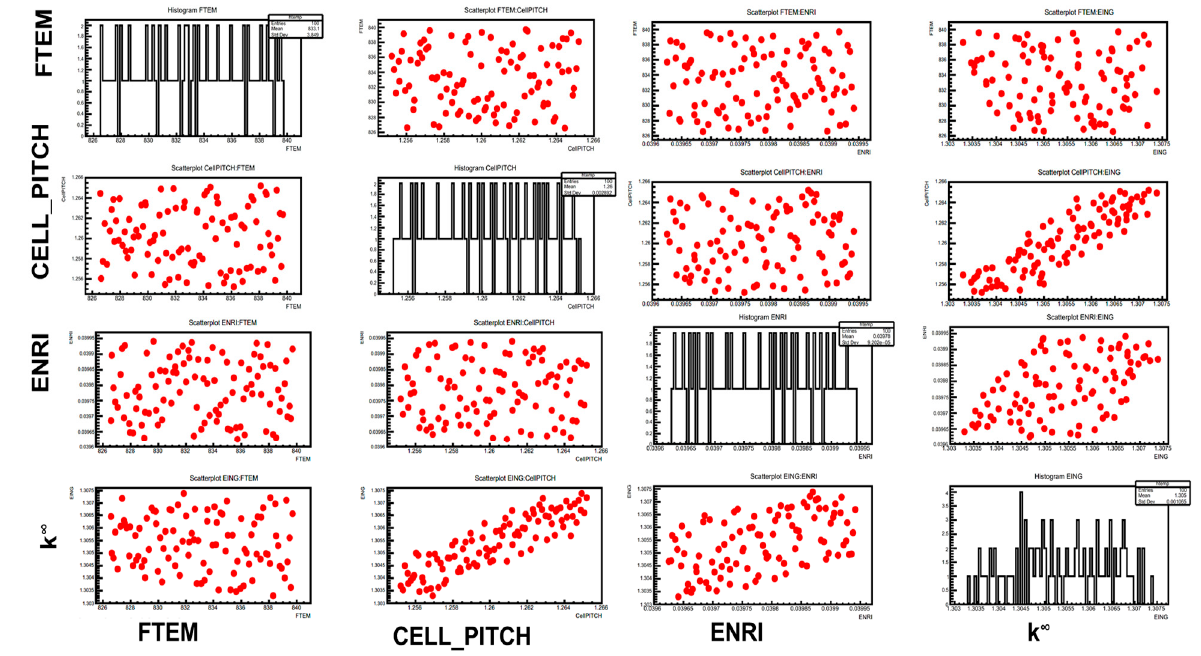
Figure 11. PWR UOX CELL: Pairs plot (FTEM, CELL_PITCH, ENRI).